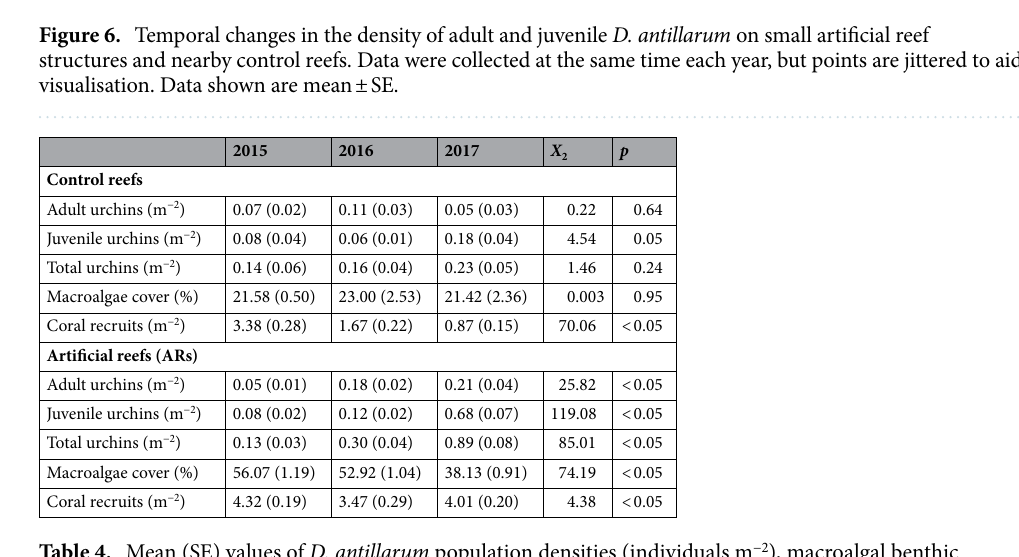
Table 4. Mean (SE) values of D. antillarum population densities (individuals m −2 ), macroalgal benthic cover (%) and juvenile coral recruit densities (individuals m −2 ) for control and artificial reefs in La Ensenada surveyed in 2015, 2016, and 2017. Also shown are the results of Friedman tests comparing